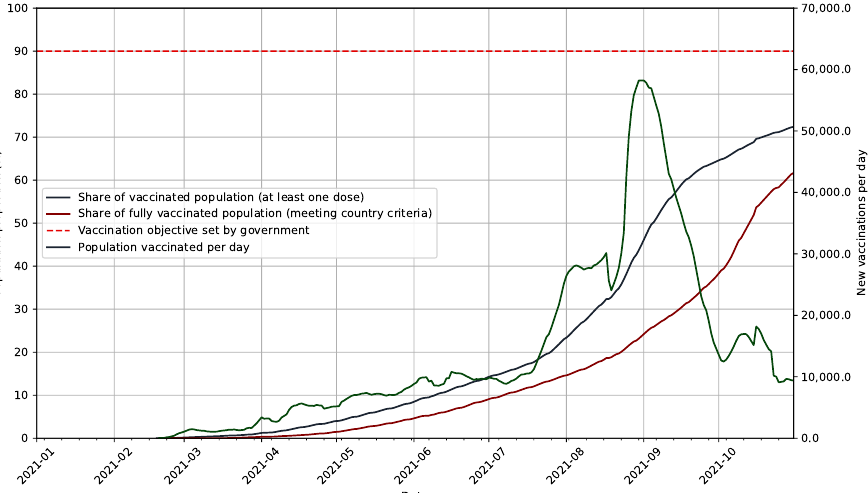
Figure 3. Evolution of vaccinated and fully vaccinated population share over time along with governmental objectives in New Zealand. Since the beginning of the vaccination campaign in February 2021, more than 70% of the population have received one dose of vaccine and more than 60% two doses with a lagging period of about a month and a half. The peak in the number of administered doses early September 2021 corresponds to the opening of vaccination to all adults above sixteen years of age. This number has decreased since and appears steady at around 10,000 vaccinations per day. The speed at which the gap between current vaccination proportion and governmental objective has been decreasing since mid-September 2021. Population vaccinated per day is smoothed with a rolling average window of 7